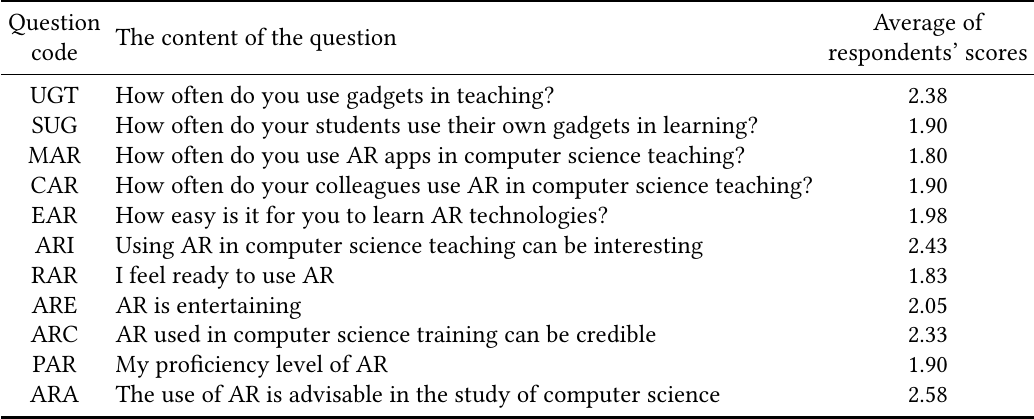
Table 3 Questionnaire items.